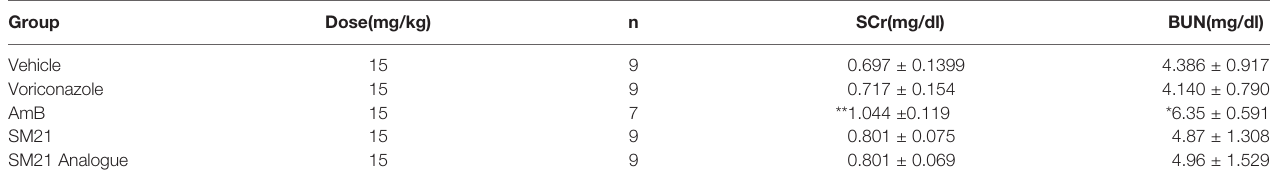
TABLE 1 | SCr and BUN were signi fi cantly increased at day 5 observed in AmB treated group whereas change of alterations of tested drug SM21 and its analogue treated groups fall in the range of negative control (voriconazole) and vehicle treated groups, but the magnitude of these alterations were much lower than that of